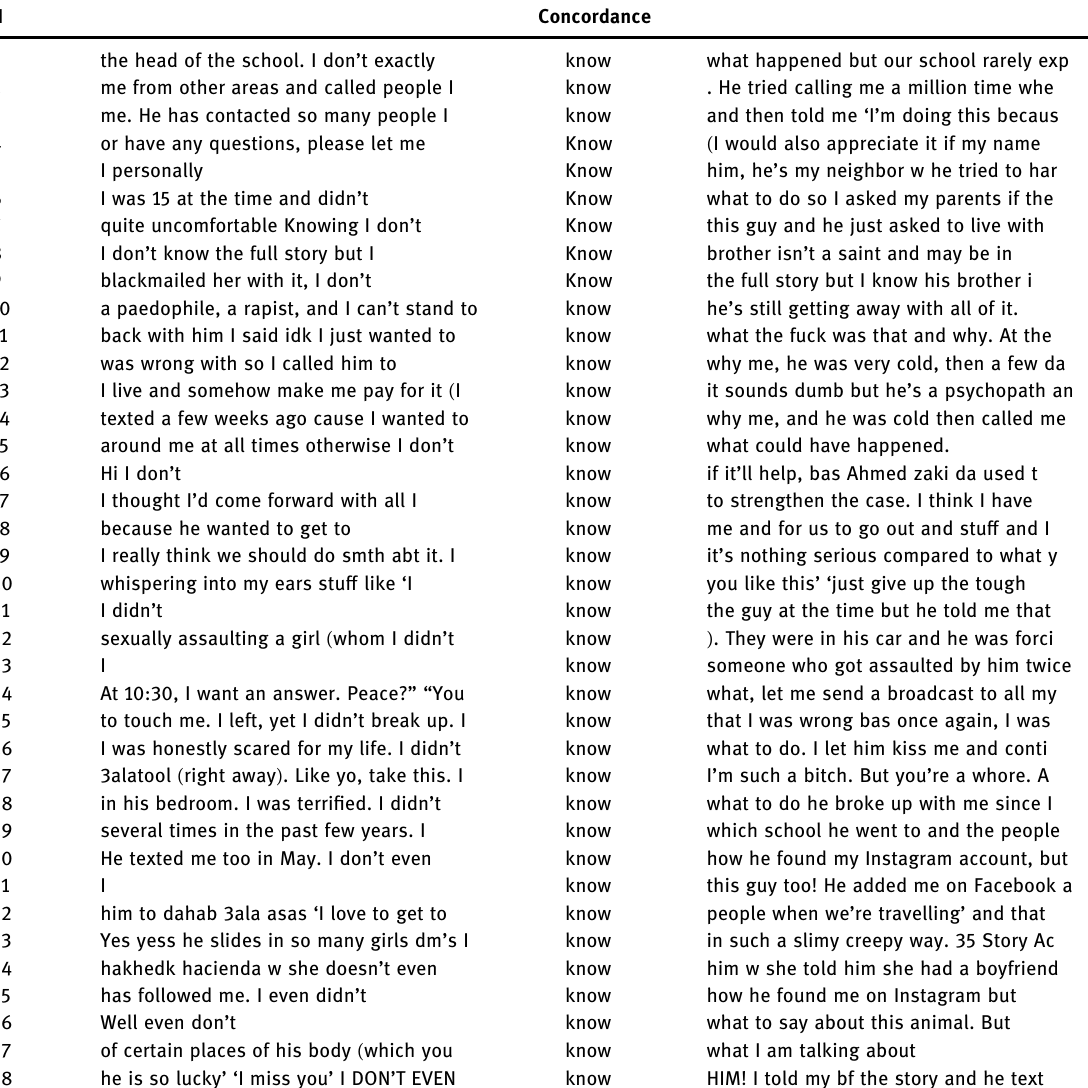
Table 6: Concordance lines for know